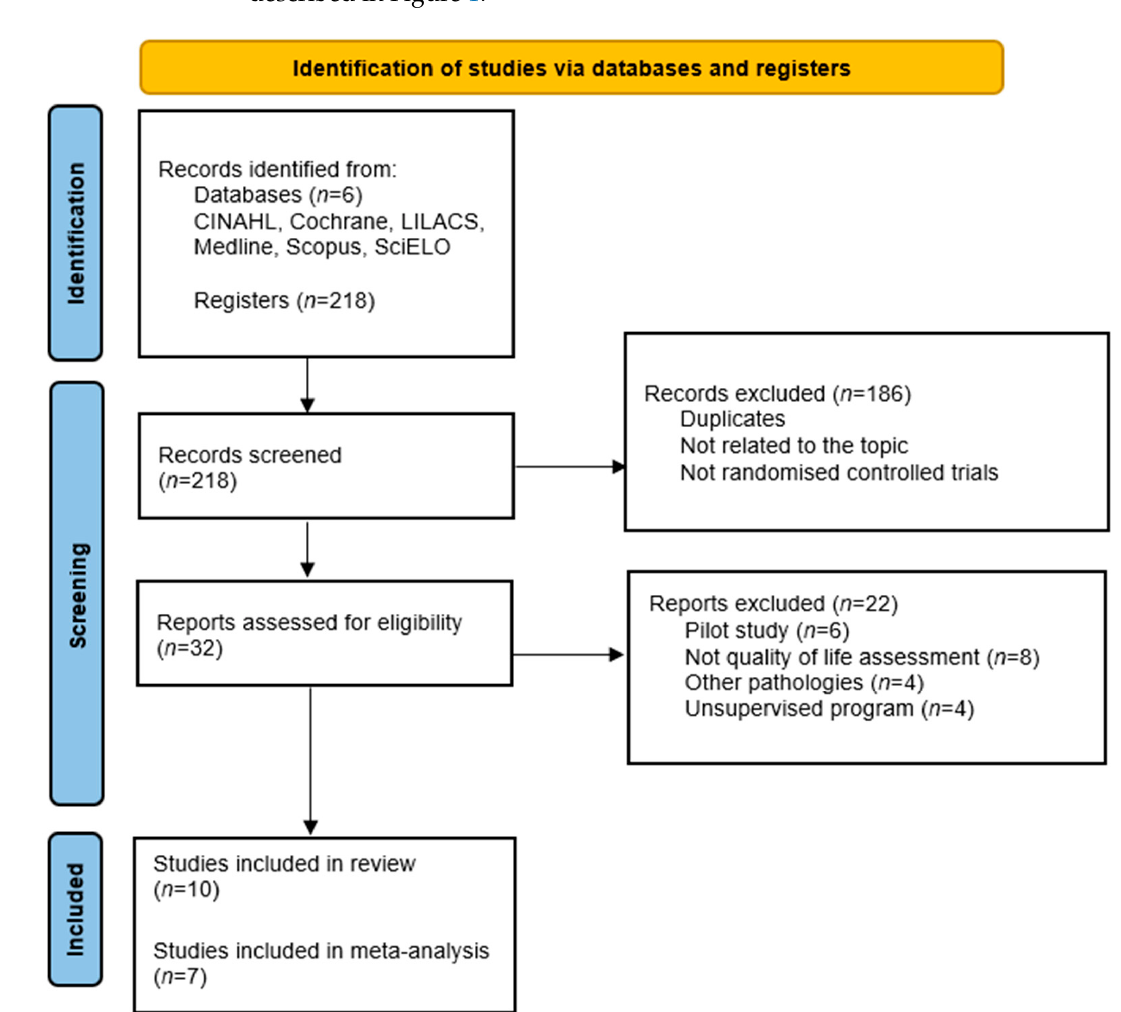
Figure 1. Flow diagram of the publication search process.